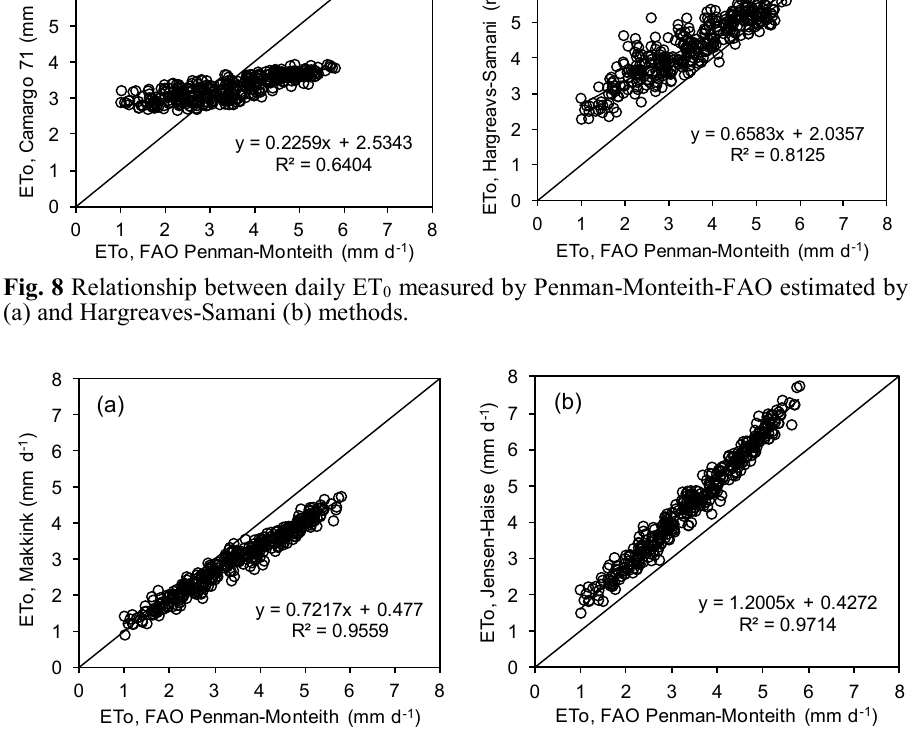
Fig. 9 Relationship between daily ET 0 measured by Penman-Monteith-FAO and estimated by the Makkink (a) and Jensen-Haise (b)